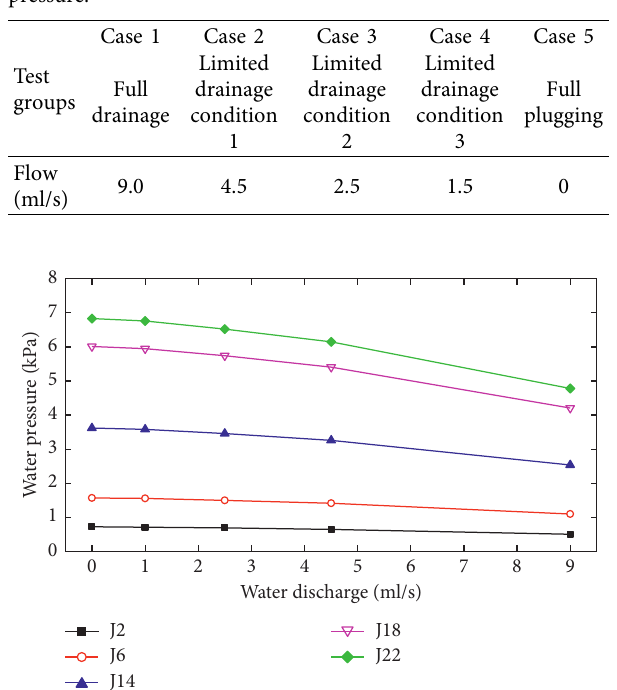
Figure 18: Relationship between the water pressure outside the pipe roof and the water discharge.